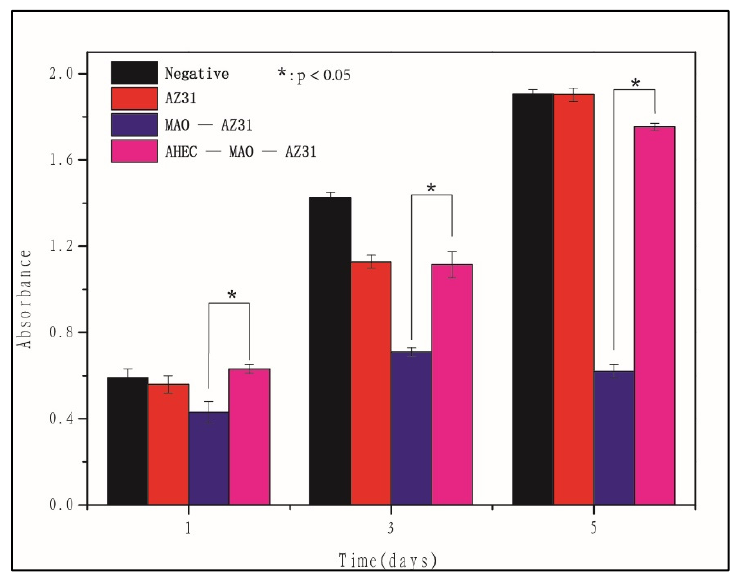
Figure 9. The cell viability of AZ31, MAO + AZ31 and AHEC + MAO + AZ31 specimens.